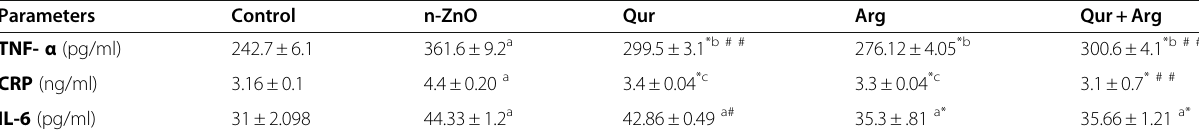
Table 1 Effect of Qur and/or Arg treatment on serum inflammatory markers level in intoxicated rats with a low dose of n-ZnO particles